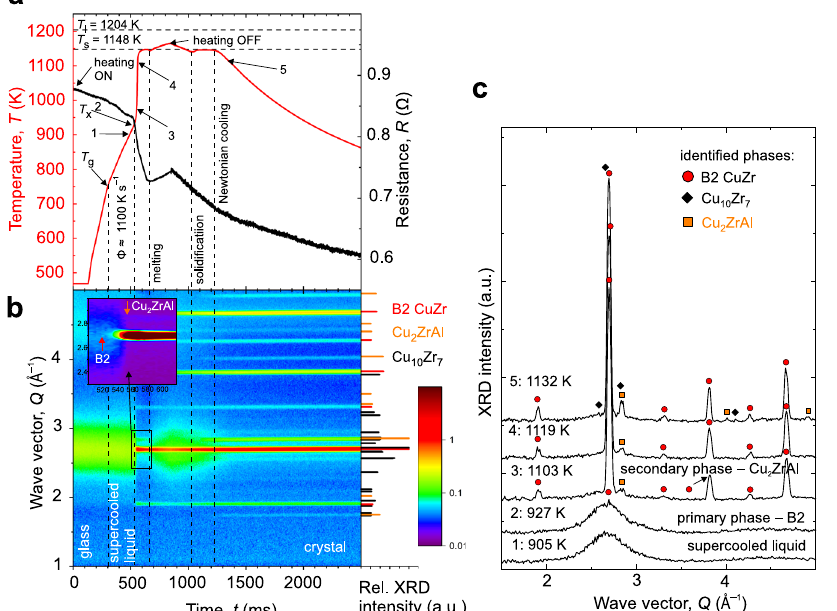
Fig. 2 In situ high-energy X-ray diffraction revealing the crystallization mechanism on fl ash-annealing at a supercritical-heating rate of the glass in a vacuum. a Time-dependent temperature (red) and resistance (black) of Cu 47.5 Zr 47.5 Al 5.0 glassy ribbon when resistively heated at a heating rate of Φ ≈ 1100 K s − 1 and cooled in a vacuum. b The corresponding temporal evolution of high-energy X-ray patterns on heating and cooling. The inset, in part b , shows a close-up of the crystallization onset for B2 (red arrow) and Cu 2 ZrAl (orange arrow) phases. Right-hand part in part b : The relative X-ray intensities are normalized to the highest-intensity peak. For clarity, only selected Cu 10 Zr 7 diffraction peaks are plotted (see Fig. 1, part b , for the complete plot). c Selected individual XRD patterns showing the different stages of crystallization and phase transformations. Full symbols label the position of the most pronounced peaks of the identi fi ed phases revealed by Rietveld re fi nement — details can be found in Supplementary Information, Supplementary Fig. 4 (heating), and Supplementary Fig. 6 (cooling). The labeled points correspond to the time of 1: 489 ms; 2: 520 ms; 3: 552 ms; 4: 566 ms; and 5: 1300 ms. Source data of the XRD patterns are provided on https://archive.materialscloud.org/ 61 . NATURE COMMUNICATIONS| (2021) 12:2839